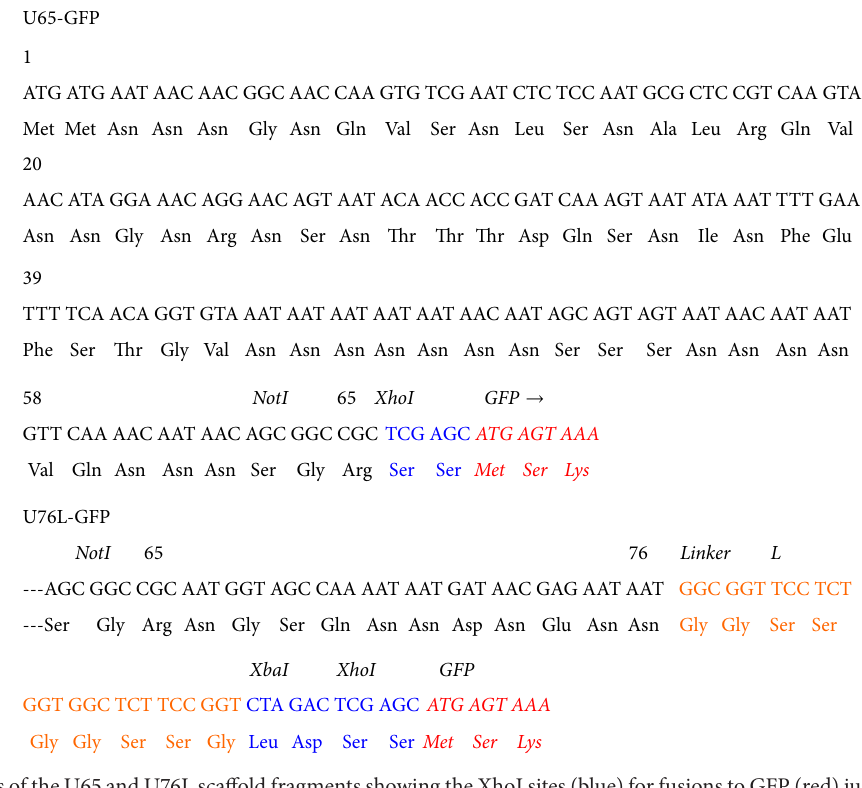
Figure 4: Sequences of the U65 and U76L scaffold fragments showing the XhoI sites (blue) for fusions to GFP (red) just upstream of the NotI site in U65 and following codon 76 and the 9-residue flexible linker (orange) in U76L.